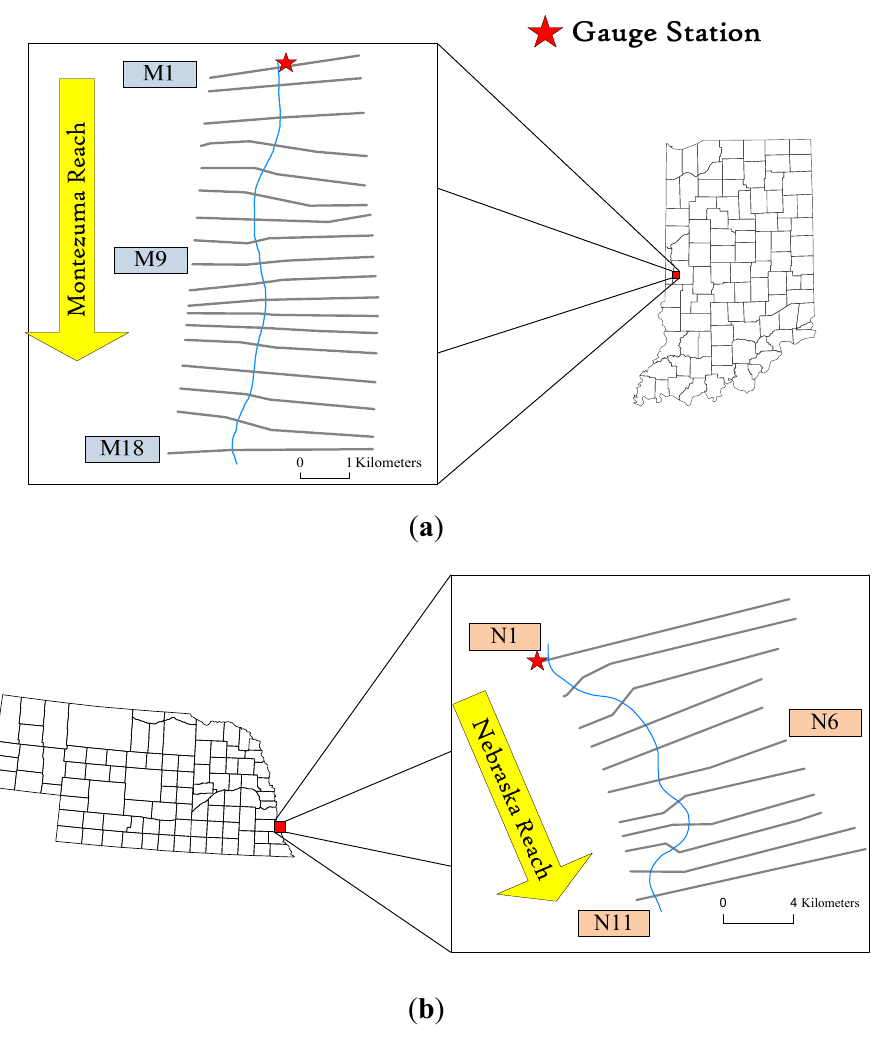
Figure 1. Study reaches. ( a ) The Wabash River at Montezuma, IN, USA (The Montezuma reach); ( b ) The Missouri River at Nebraska City, NE, USA (The Nebraska reach).